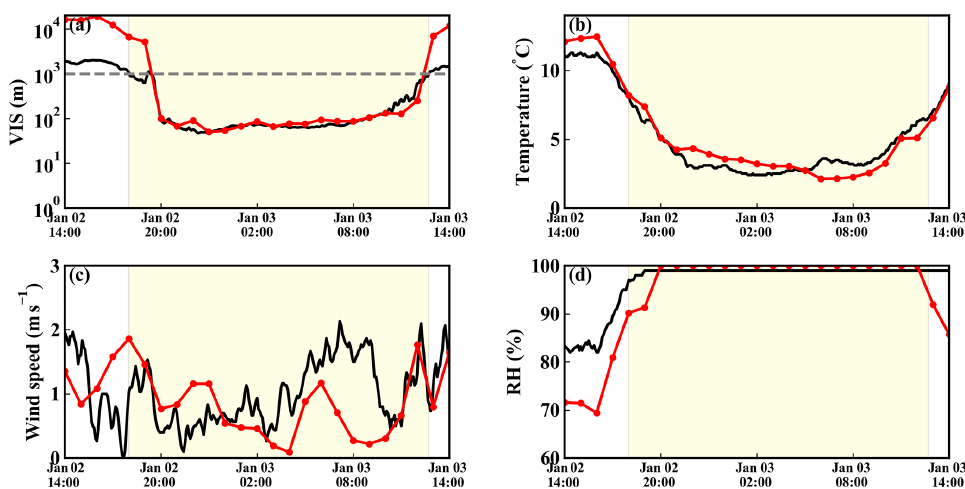
Figure 4. The performance of the simulated meteorological parameters at the SX site. (a) VIS, (b) air temperature, (c) 10min average wind speed and (d) relative humidity (RH). The red dotted lines represent the model results, and the black lines are the observations. The fog period (VIS < 1km and RH > 90%) is shaded in light